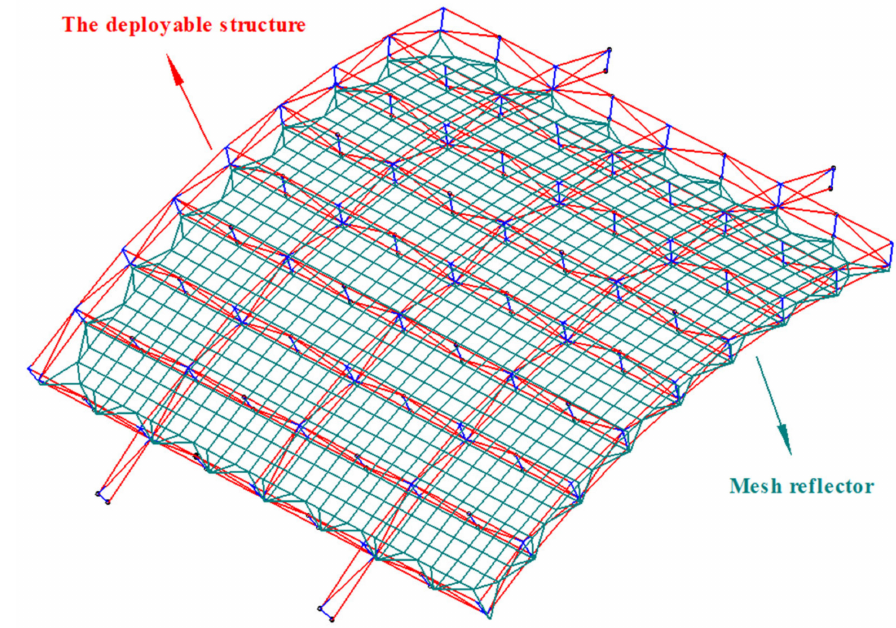
Figure 1. The deployable parabolic cylinder antenna.